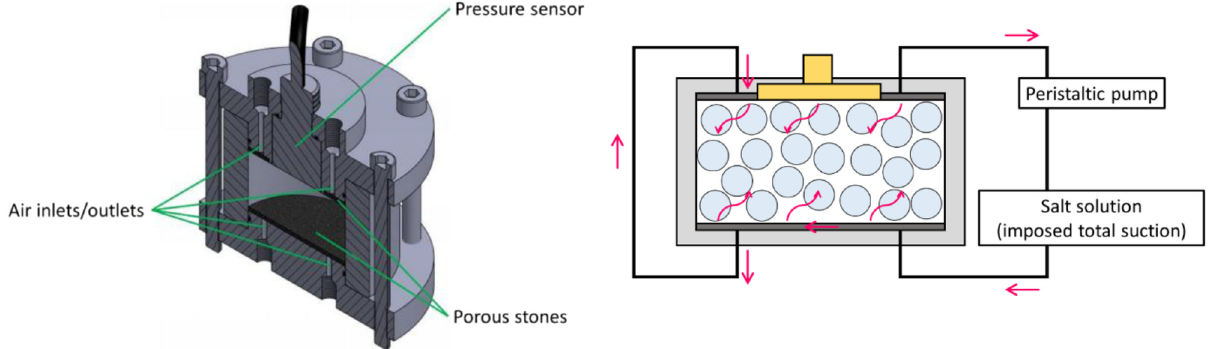
Fig. 3. Diagram of the experimental apparatus used for swelling pressure tests: left, 3D view of the isochoric cell and right, sketch of the suction control